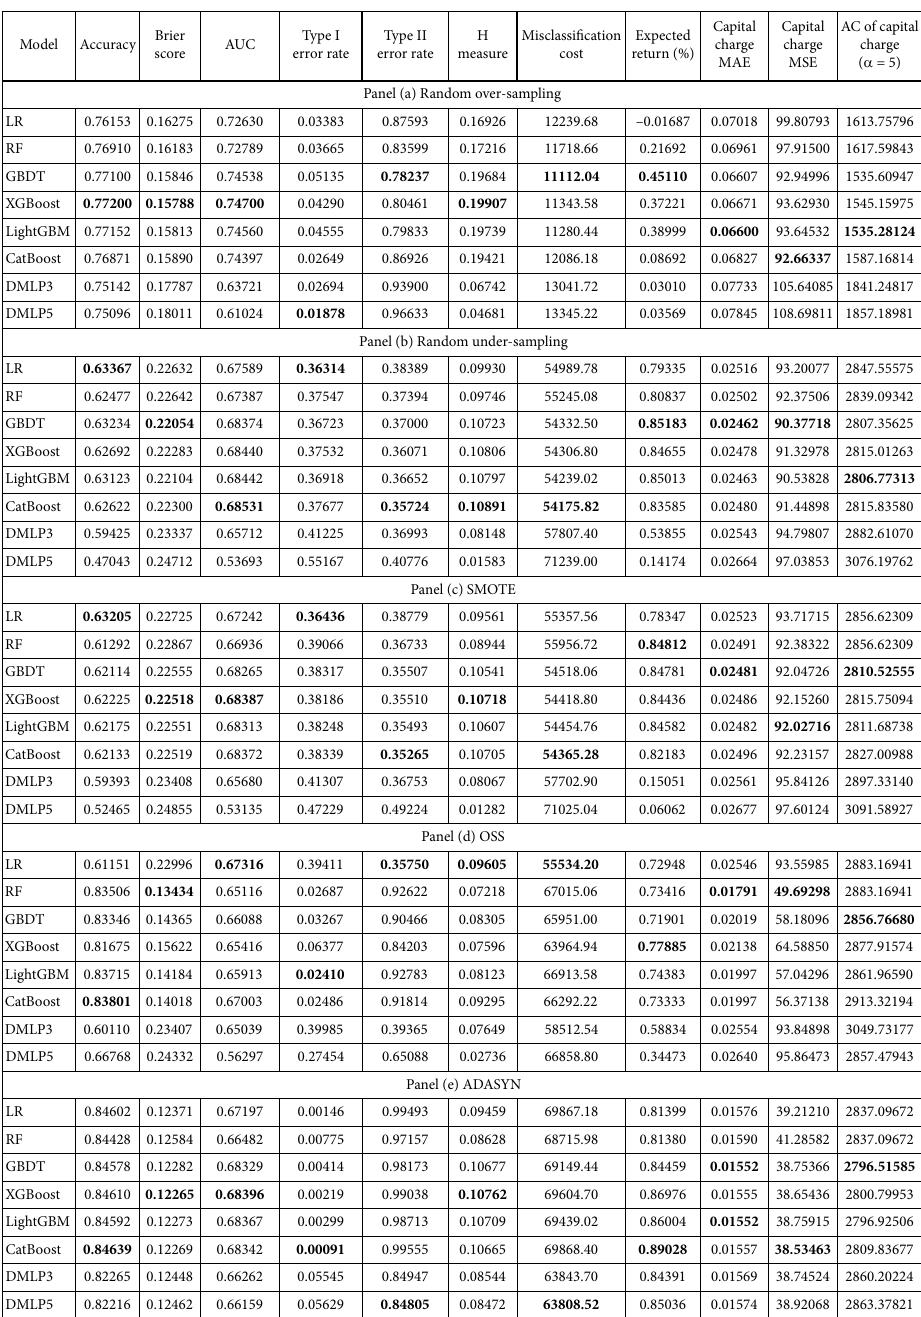
Table 5. Results of out-of-sample validation for Lending club dataset (with sampling techniques) Model Accuracy Brier